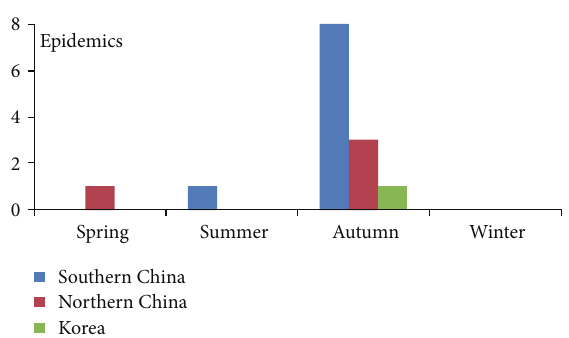
Figure 3: Seasonal variation of the number of records of epidemic in 1601 AD in southern China, northern China, and